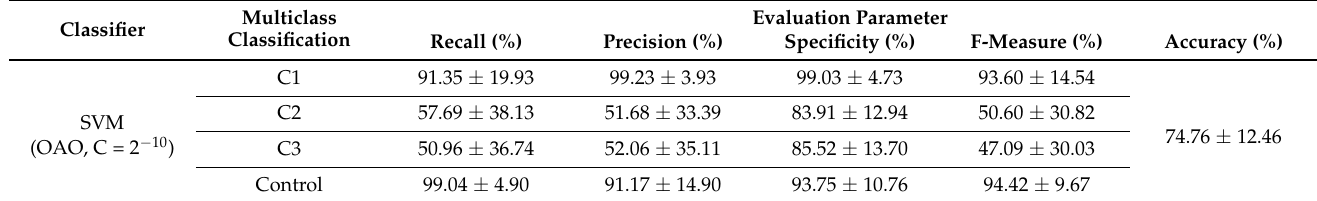
Figure 6. p -values of the pairwise comparison of the classification model options, with Bonferroni correction. The values higher than the significance level of 0.05 are colored with light blue, while the intermediate blue is related to a significance level of 0.05 and dark blue to a significance level of 0.01. PCA: Principal Component Analysis; Krusk: Kruskal-Wallis H test; NMI: Normalized Mutual Information; Reli: ReliefF Algorithm; SVM: Support Vector Machine; FLDA: Fisher Linear Discriminant Analysis classifier; kNN: k-nearest neighbors algorithm; Naive: Naive Bayes classifier. Based on the above, we will present herein the classification results obtained for the example of the option using PCA algorithm and the SVM classifier (see Table 3). Table 3. Multiclass classification results considering software metrics